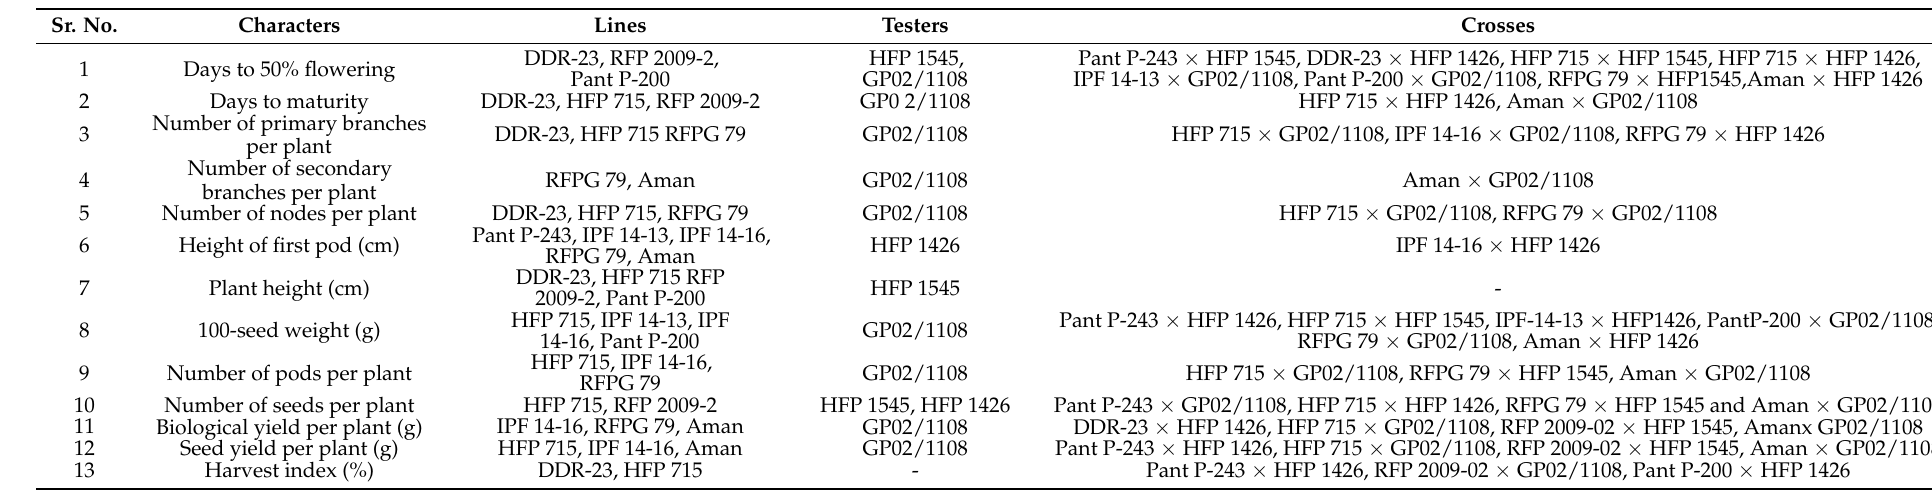
Table 6. Lines, testers, and crosses possess good GCA and SCA effects for different traits in field